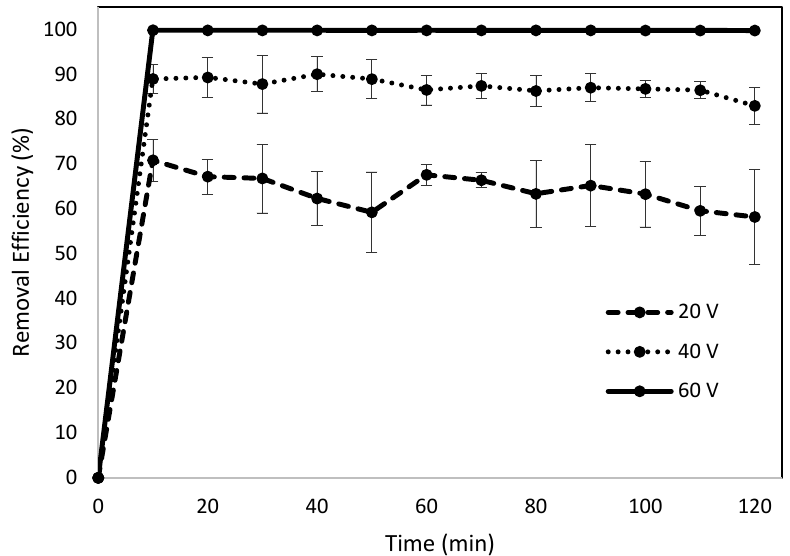
Figure 6. The effects of three different voltages on removal efficiency over a 120 min period (bead size = 200 µm, flow rate = 1.0 mL/min).